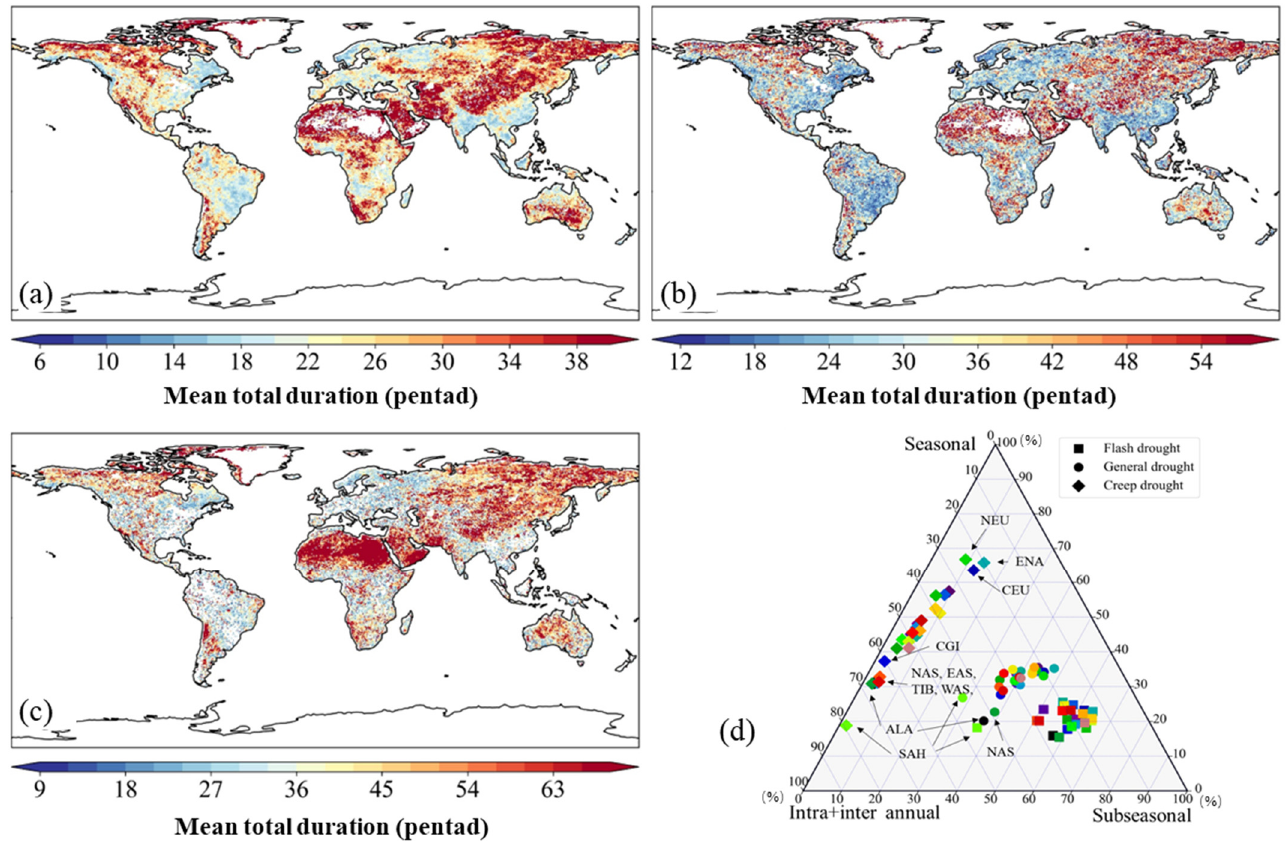
Figure 7. Similar to Figure 6 but for the mean total duration of flash drought ( a ), general drought ( b ), and creep drought ( c ). Each point in ( d ) represents a specific drought type for a region, and its position reflects how many events belonging to sub-seasonal (<3 months), seasonal (3–6 months), and intra-annual or inter-annual (>6 months), respectively.